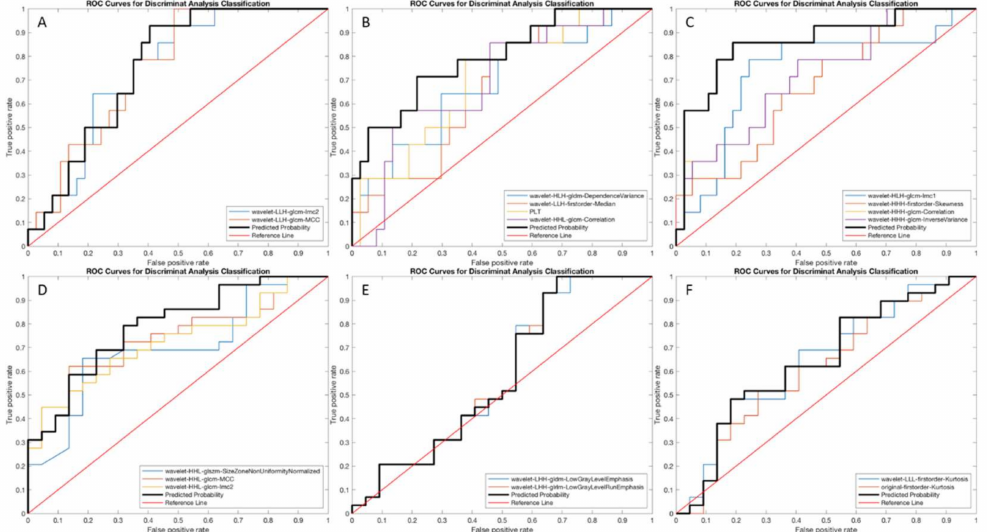
Figure 5. ROC curves of the Discriminant Analysis (radiomics model 2) for predicting complete response on portal-venous ( A ), 3 (cid:48) transitional ( B ), and hepatobiliary ( C ) phases, and for the prediction of objective response on portal-venous ( D ), 3 (cid:48) transitional ( E ), and hepatobiliary ( F )